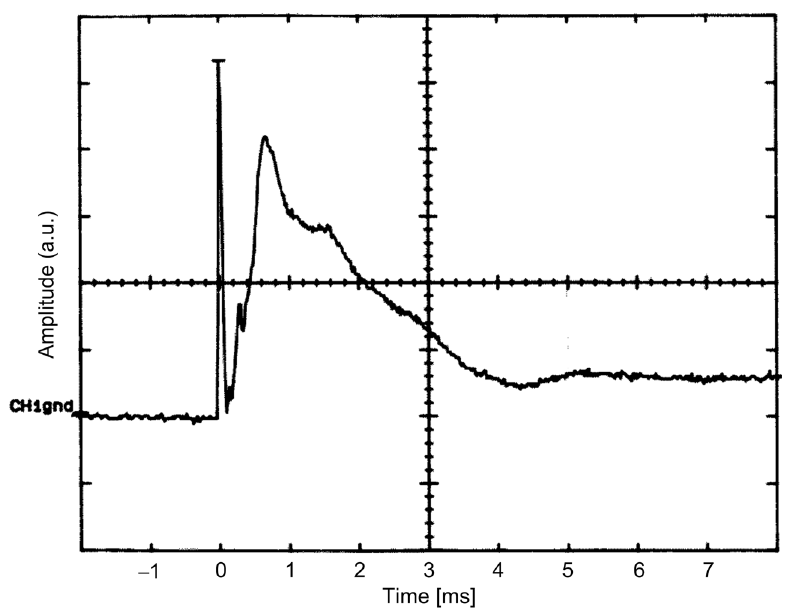
Figure 5. Overlapped inrush events as caused by EMI filter Cy capacitors and leveling capacitors of